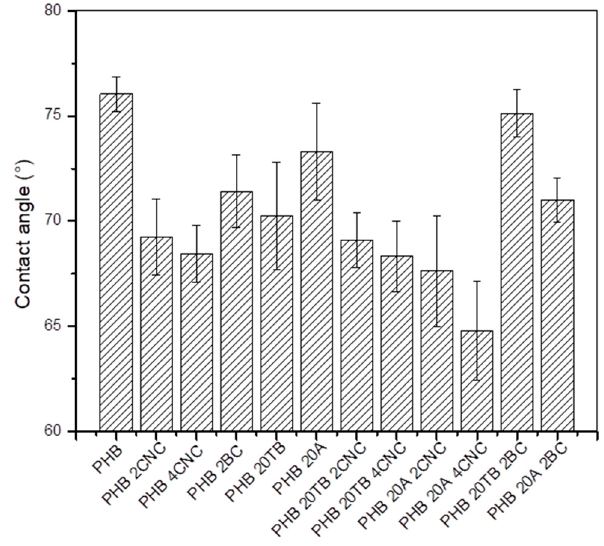
Figure 7. Contact angles of PHB nanocomposites and plasticized samples.